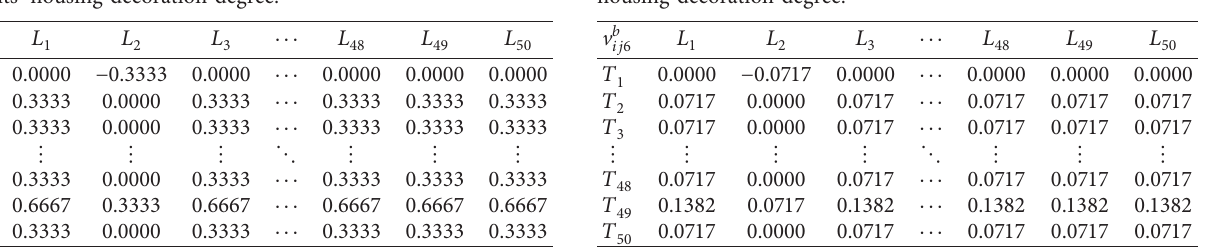
� [ v b ] for tenants’ ij 6 50 × 50 6